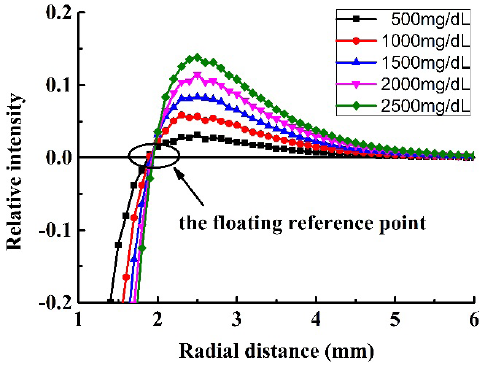
Fig. 1. The FRP of glucose in 2% Intralipid solution by simulation.